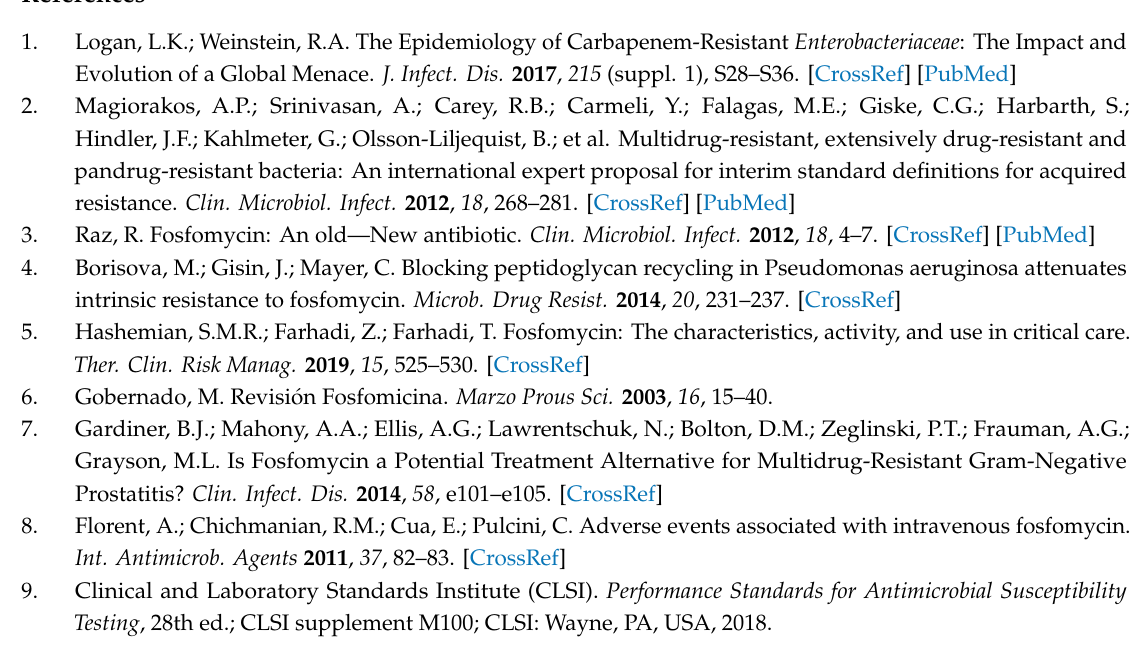
Table S1: Susceptibility test